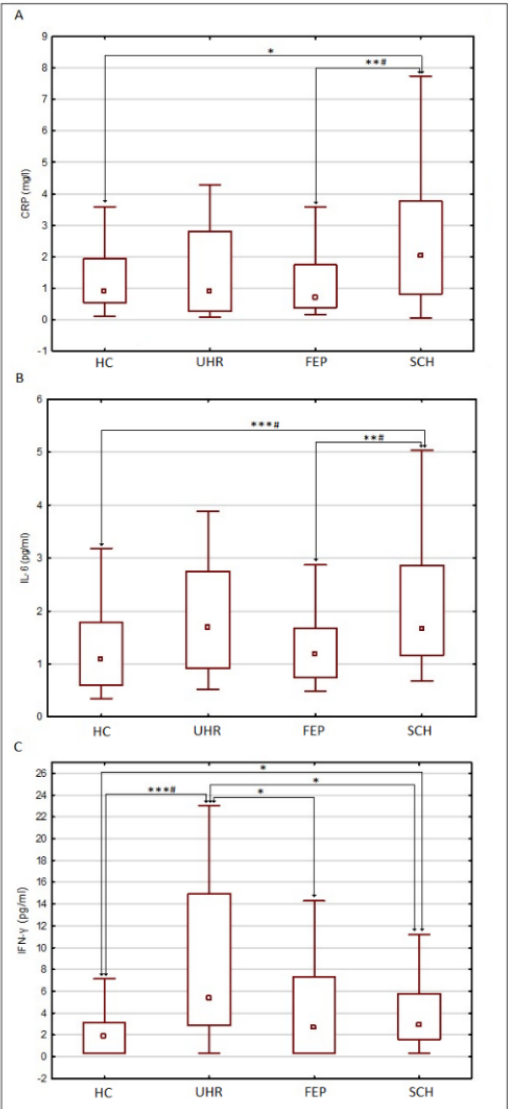
Figure 2. Comparison between groups of the serum concentrations of ( A ) CRP, ( B ) IL-6, and ( C ) IFN- γ . HC-healthy controls, UHR-patients with ultra-high risk of developing psychosis, FEP-patients with first episode psychosis, SCH-patients with chronic schizophrenia, CRP—C-reactive protein, IL-6—interleukin-6, IFN- γ —interferon- γ . Data presented as median (point), interquartile range (box), and non-outlier range (whiskers), * p < 0.05, ** p < 0.01, *** p < 0.001 (without correction for multiple comparisons); # significant differences after correction for multiple